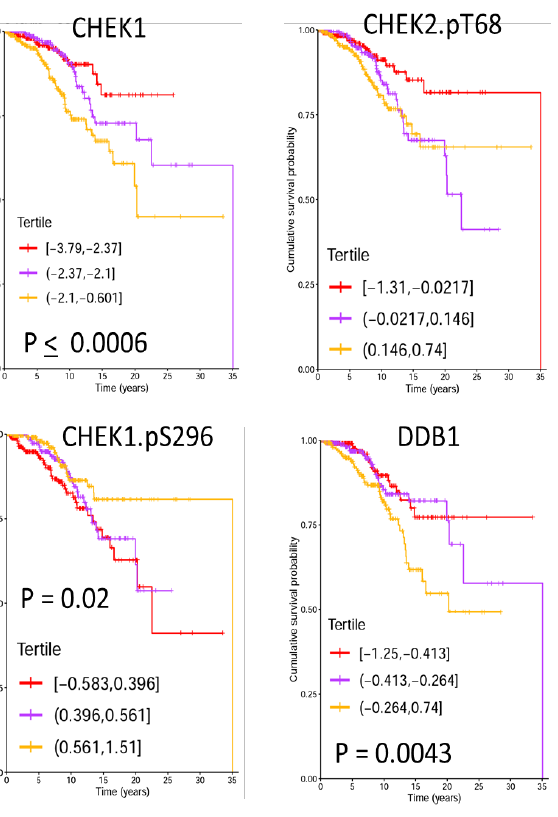
Figure 5. DDR proteins that are individually prognostic of overall survival or time to first treatment. The Kaplan – Meier plots of five proteins that were individually prognostic of overall survival and the two proteins individually prognostic of the time to first treatment in CLL are shown. All proteins were divided into terciles with the lowest expression in red, middle in purple, and highest in yellow.